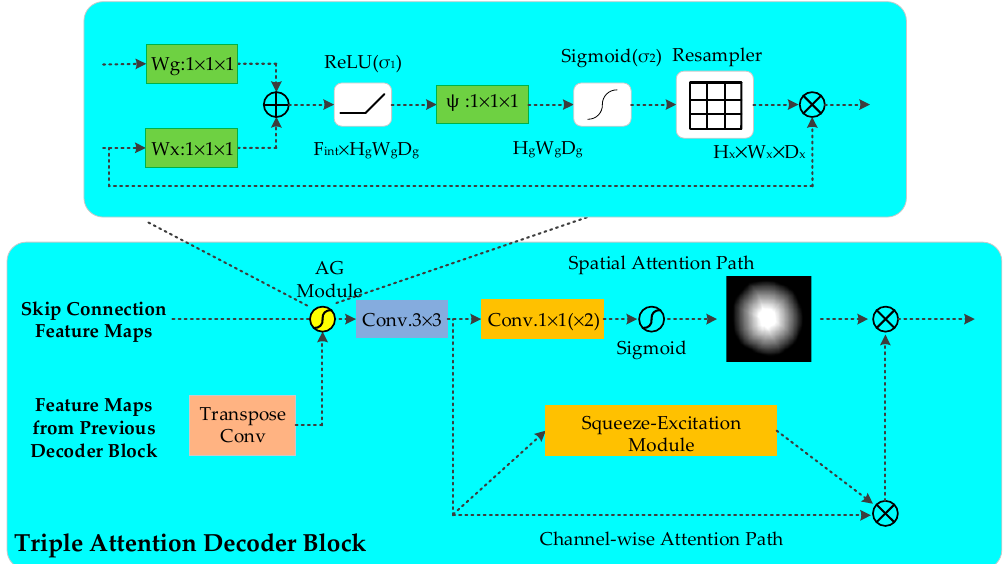
Figure 5. Triple attention decoder block. The proposed attentional decoding module consists of three modules: the AG module for skipping the connection layer to suppress irrelevant information, the spatial attention module, and the channel attention module for fusing the input features together to improve the performance of the